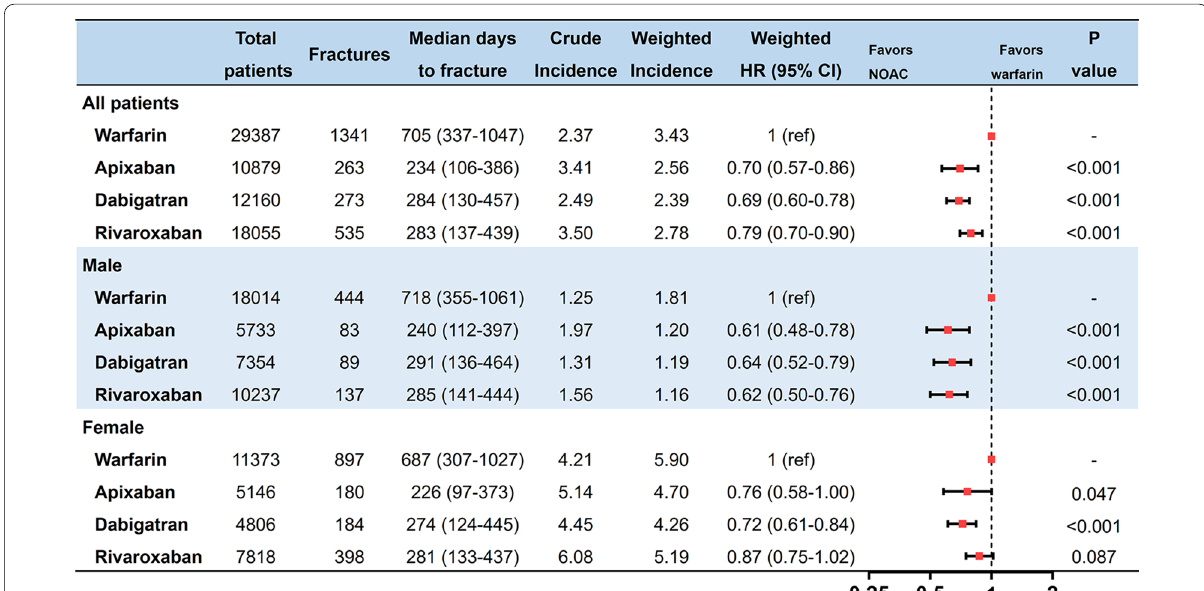
Fig. 2 Risk of major fracture after inverse probability of treatment weighting. Incidence rates are per 100 person‑years. CI confidence interval, HR hazard ratio, NOAC non‑vitamin K antagonist oral